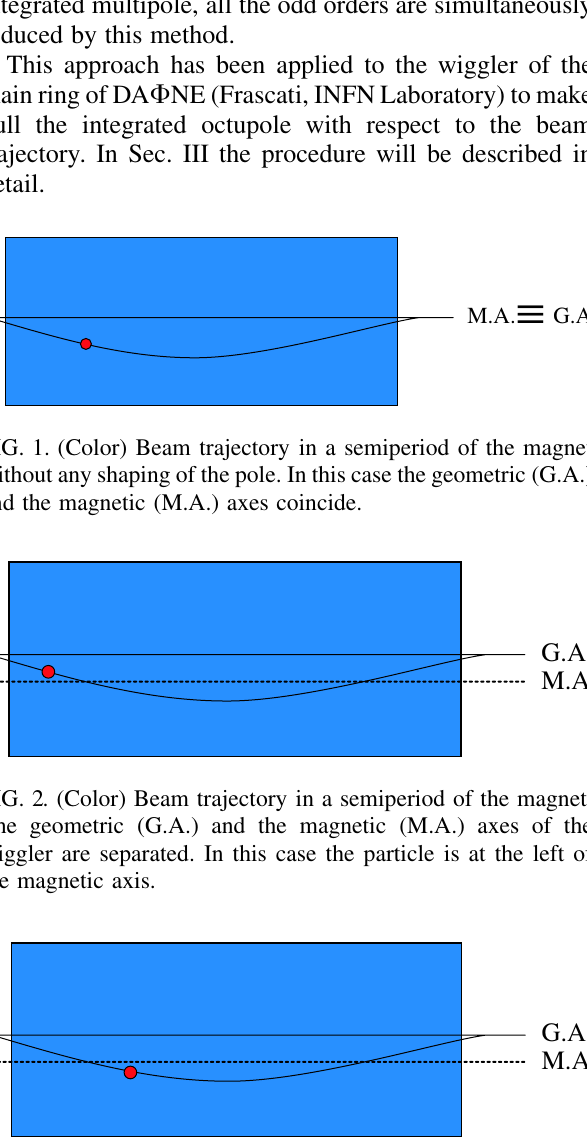
FIG. 3. (Color) Beam trajectory in a semiperiod of the magnet. The geometric (G.A.) and the magnetic (M.A.) axes of the wiggler are separated. In this case the particle is at the right of the magnetic